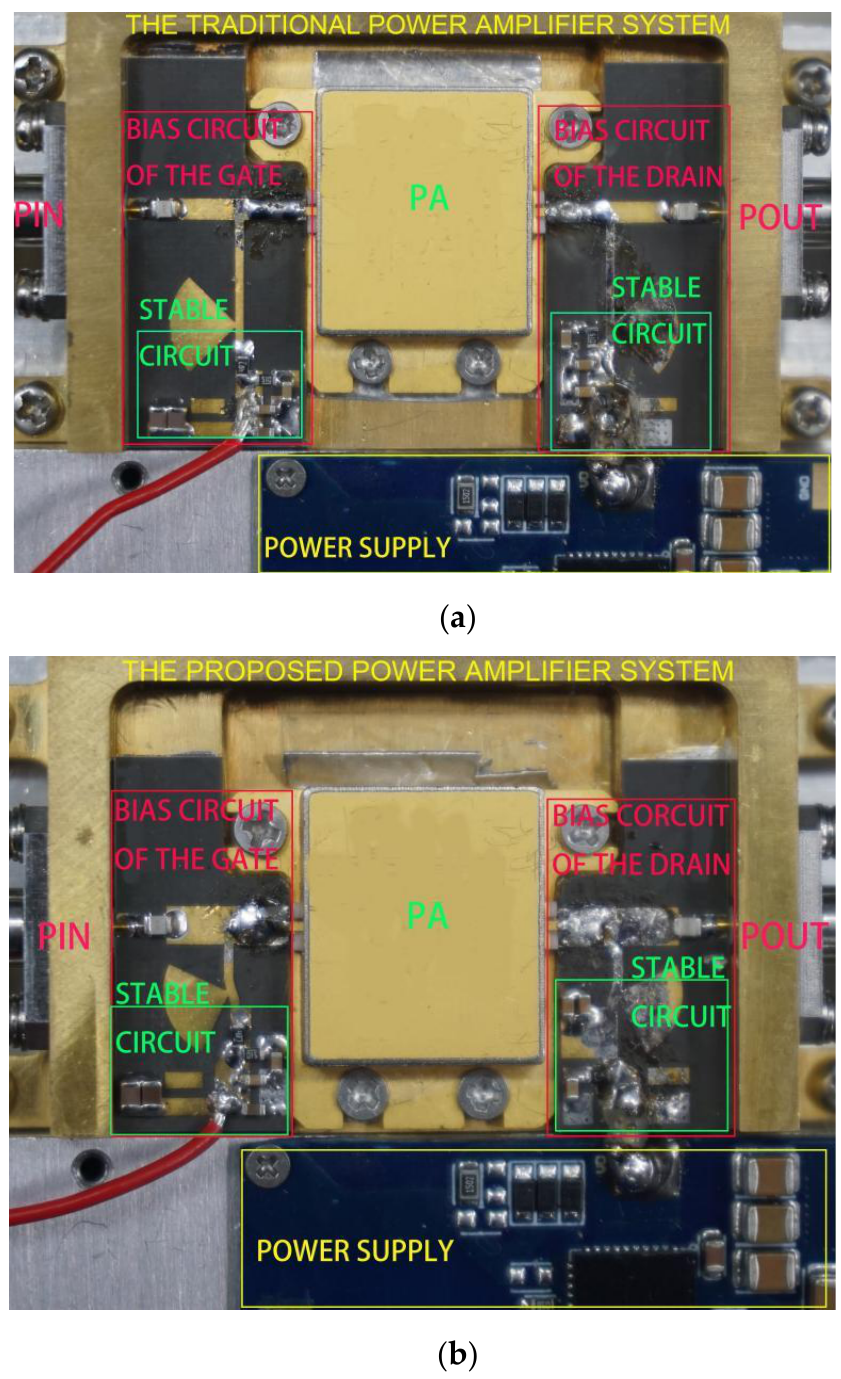
Figure 13. The power-amplifier system composed of the gate bias circuit, the drain bias circuit, and the power amplifier. ( a ) The traditional power-amplifier system. ( b ) The proposed power-amplifier system.